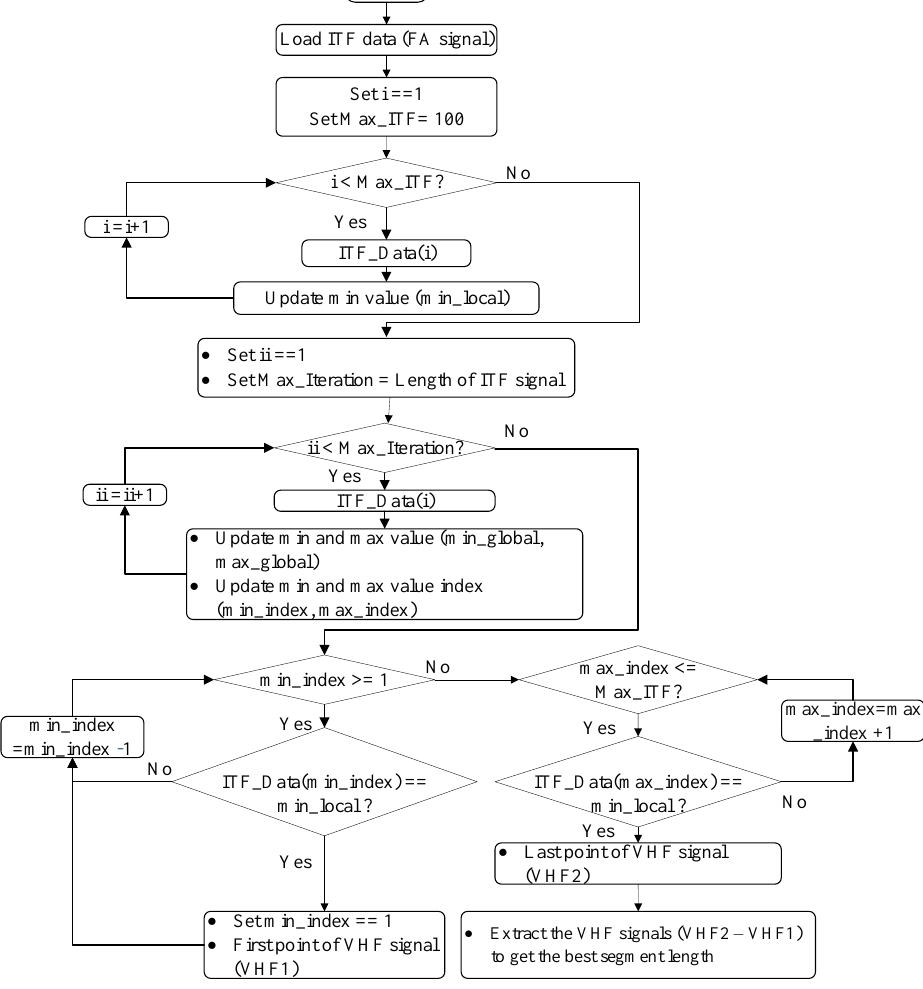
Figure 2. The lightning event extraction algorithm.